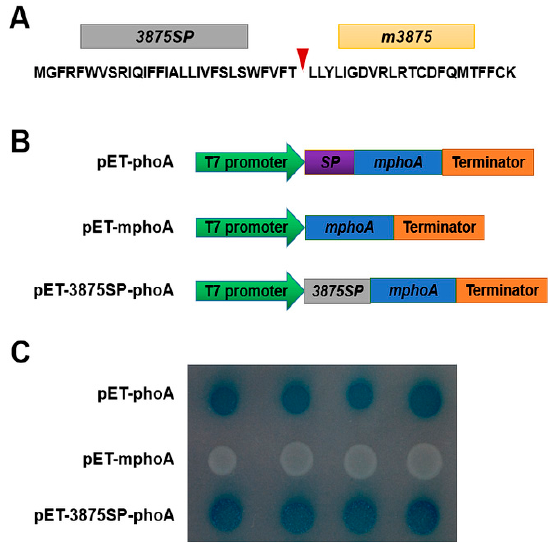
Figure 1. CLIBASIA_03875 is a Sec-dependent secretory protein. ( A ) Primary structure of CLIBASIA_03875. The triangle indicates the putative cleavage site. The putative signal peptide (SP) was designated 3875SP, and the mature form of CLIBASIA_03875 was designated m3875. ( B ) Diagrams of the prokaryotic expression cassettes for the phoA gene. pET-phoA harboring the